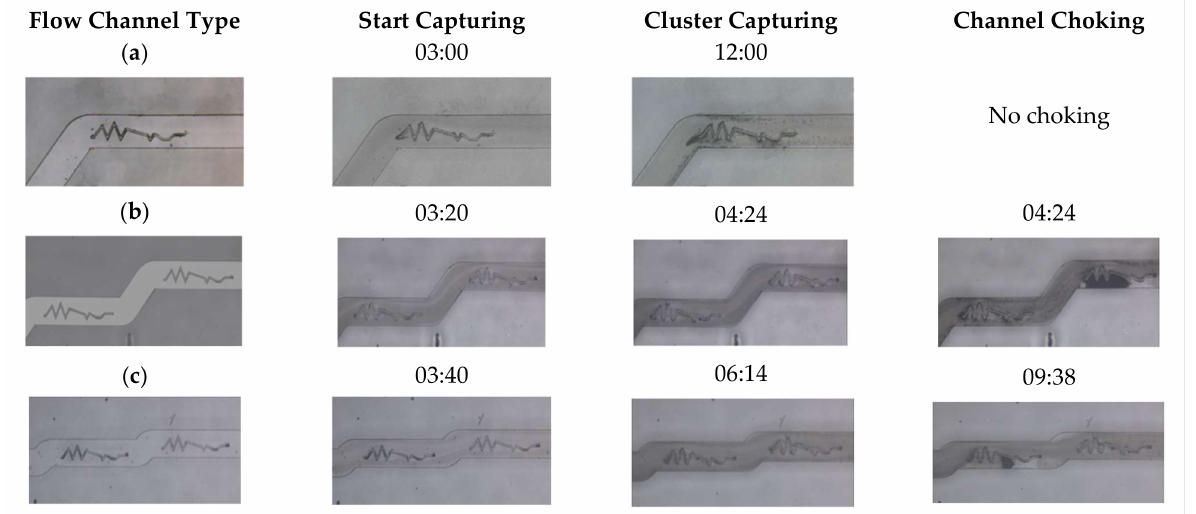
Figure 1. Choking of micro-silica microspheres applied to flow channels of different configurations. ( a ) Single wing; ( b ) Stepwise-cascaded wings; ( c ) In-series cascaded wings. Adapted with permis- sion from [21]. Copyright Year: 16 November 2022. Copyright Owner: Pang-Lun Wang, License number: